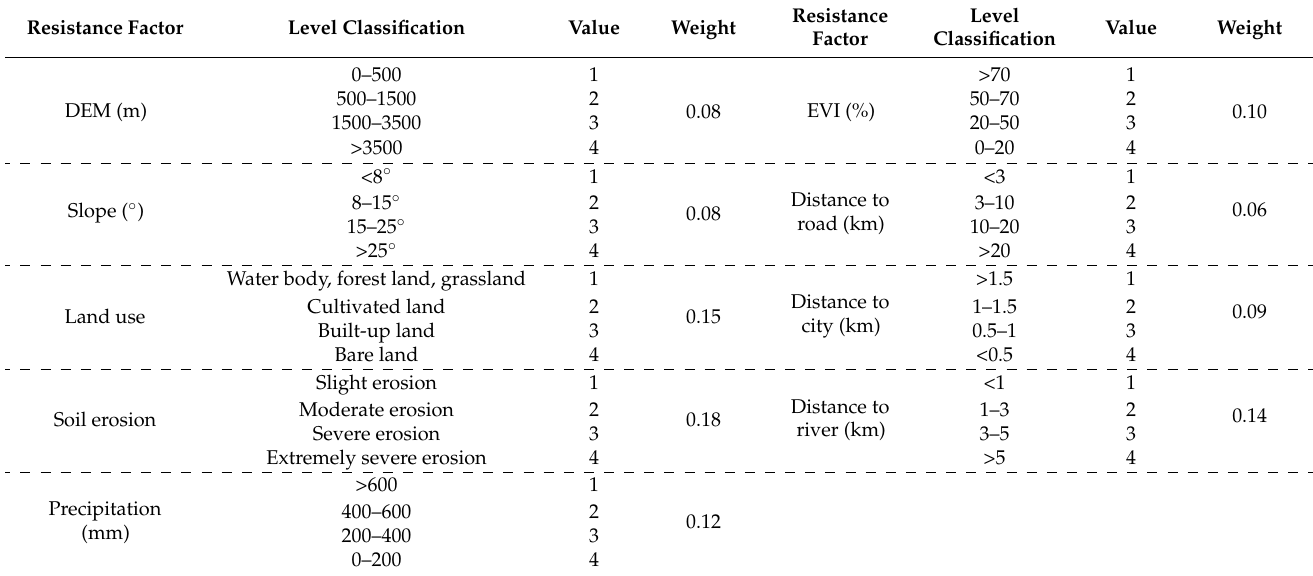
Table 3. The selected resistance factors and their classification